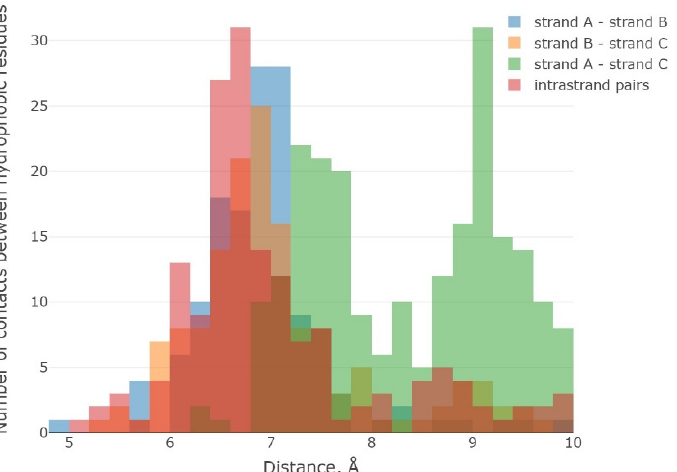
Figure 6. Distribution of distances between interacting hydrophobic amino acid residues in 3ß-corners: within one β -strand (“inside-strand”) and between different β -strands (“cross-strand”): red color indicates contacts within one strand, blue color indicates contacts of hydrophobic amino acid residues between β -strands A and B, yellow color designates contacts between β -strands B and C, and green color specifies contacts between β -strands A and C.